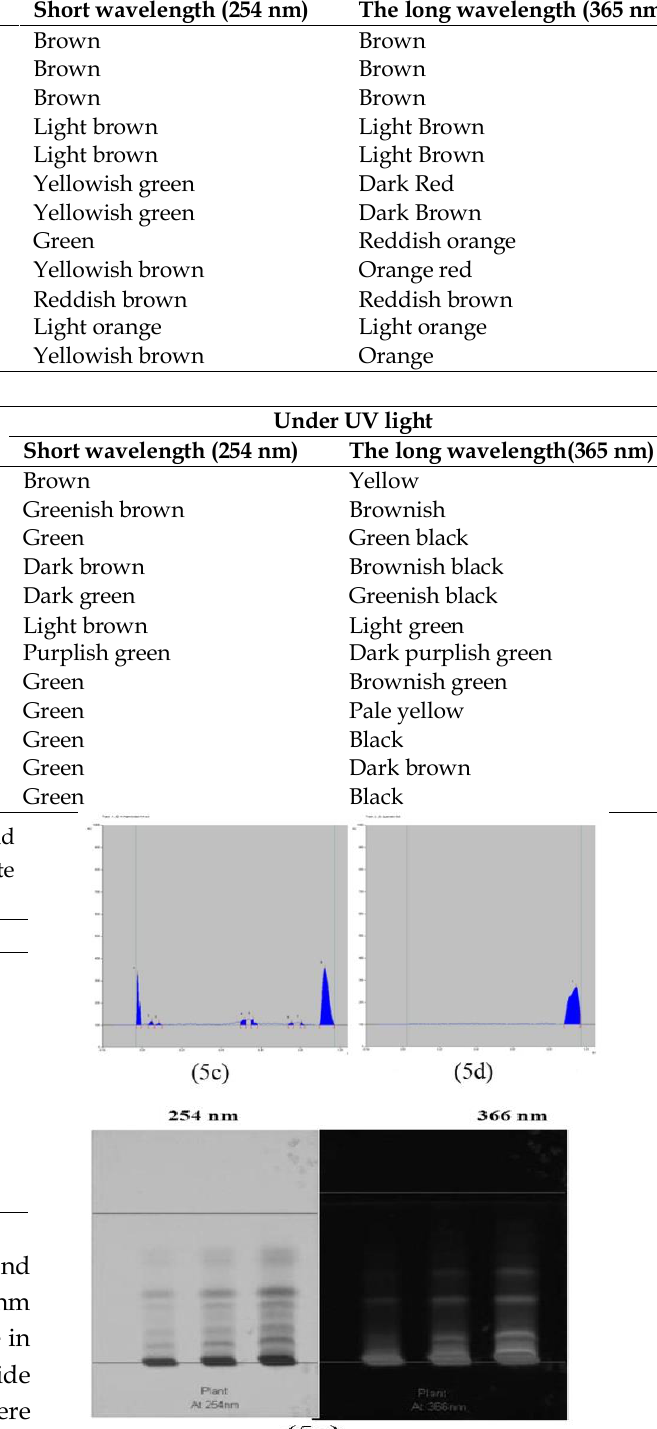
Table 7d: Fluorescence analysis of combined herb-herb Treatment